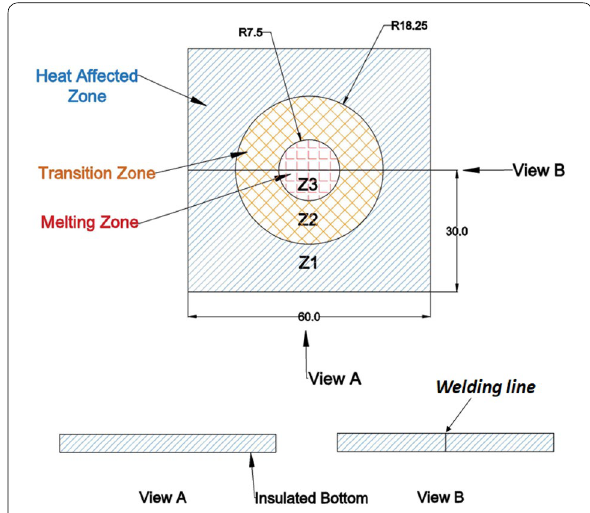
Fig. 3 Illustration of heat zones for the receiver in the Solar welding